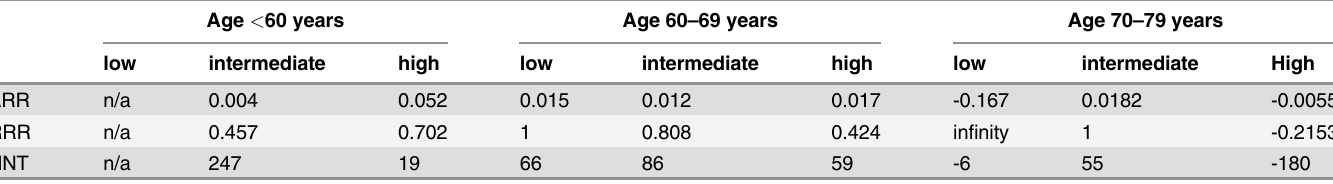
ARR- absolute risk reduction, RRR — relative risk reduction, NNT-numbers needed to